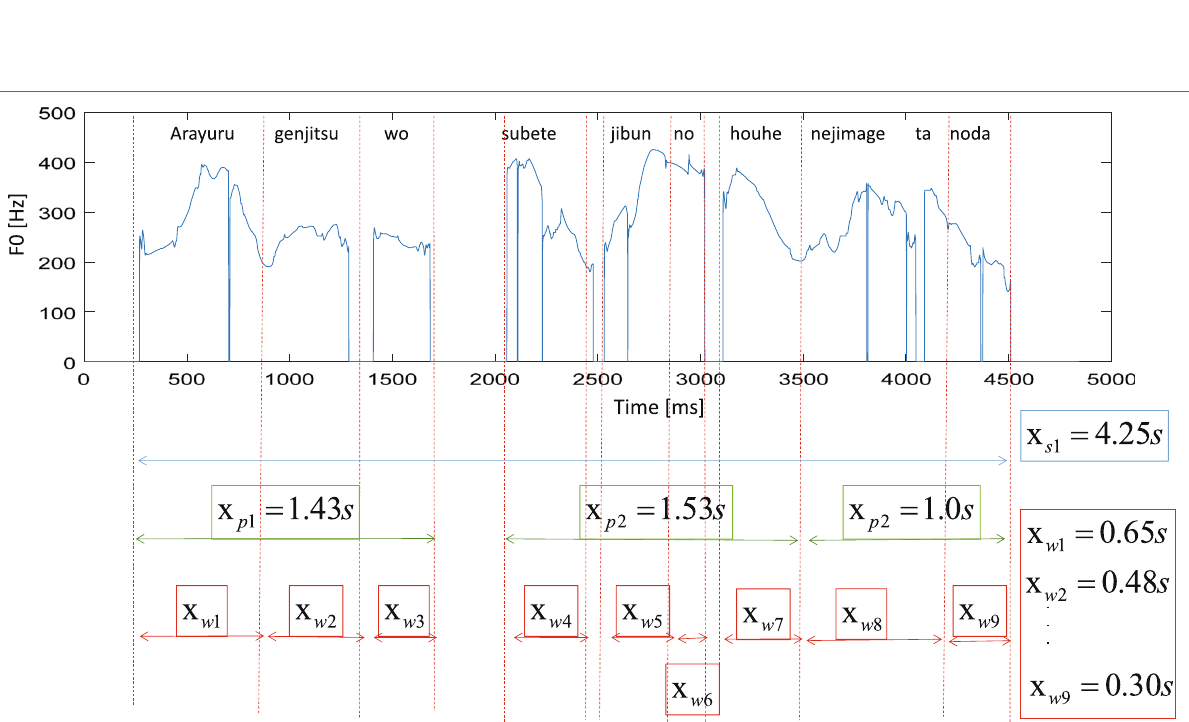
Fig. 2 Example of performing segmentation in the training data. Here, X s , X p , and X w represent the durations of sentence, phrase, and word,